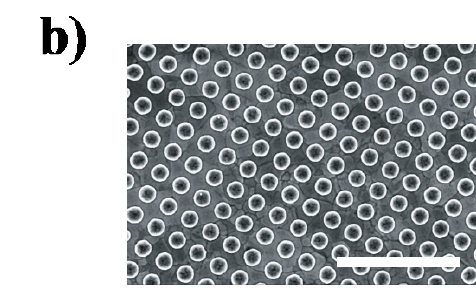
Figure 1. ( a ) Scheme of gold nanocylinders deposited on a gold thin film ( D : nanocylinder diameter, h : nanocylinder height, P : grating period, d : film thickness); ( b ) SEM image of nanocylinders with a 250 nm diameter on a gold film (scale bar: 2 µ m).